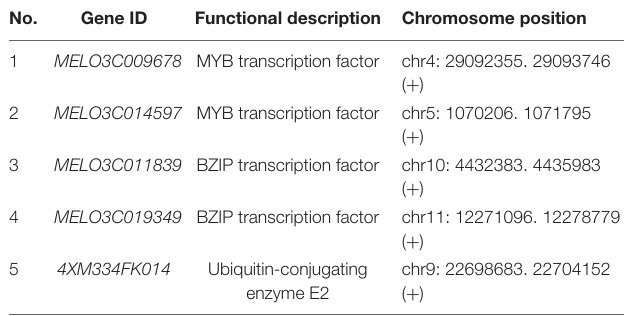
TABLE 3 | The comparative results of Y2H interaction genes.